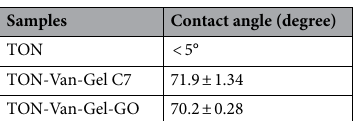
Table 3. Water contact angle measurements of samples.